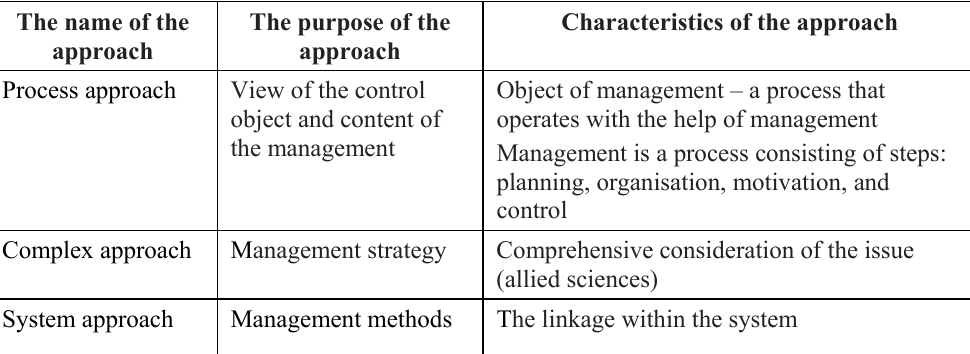
Table 1. System, Process, and Complex